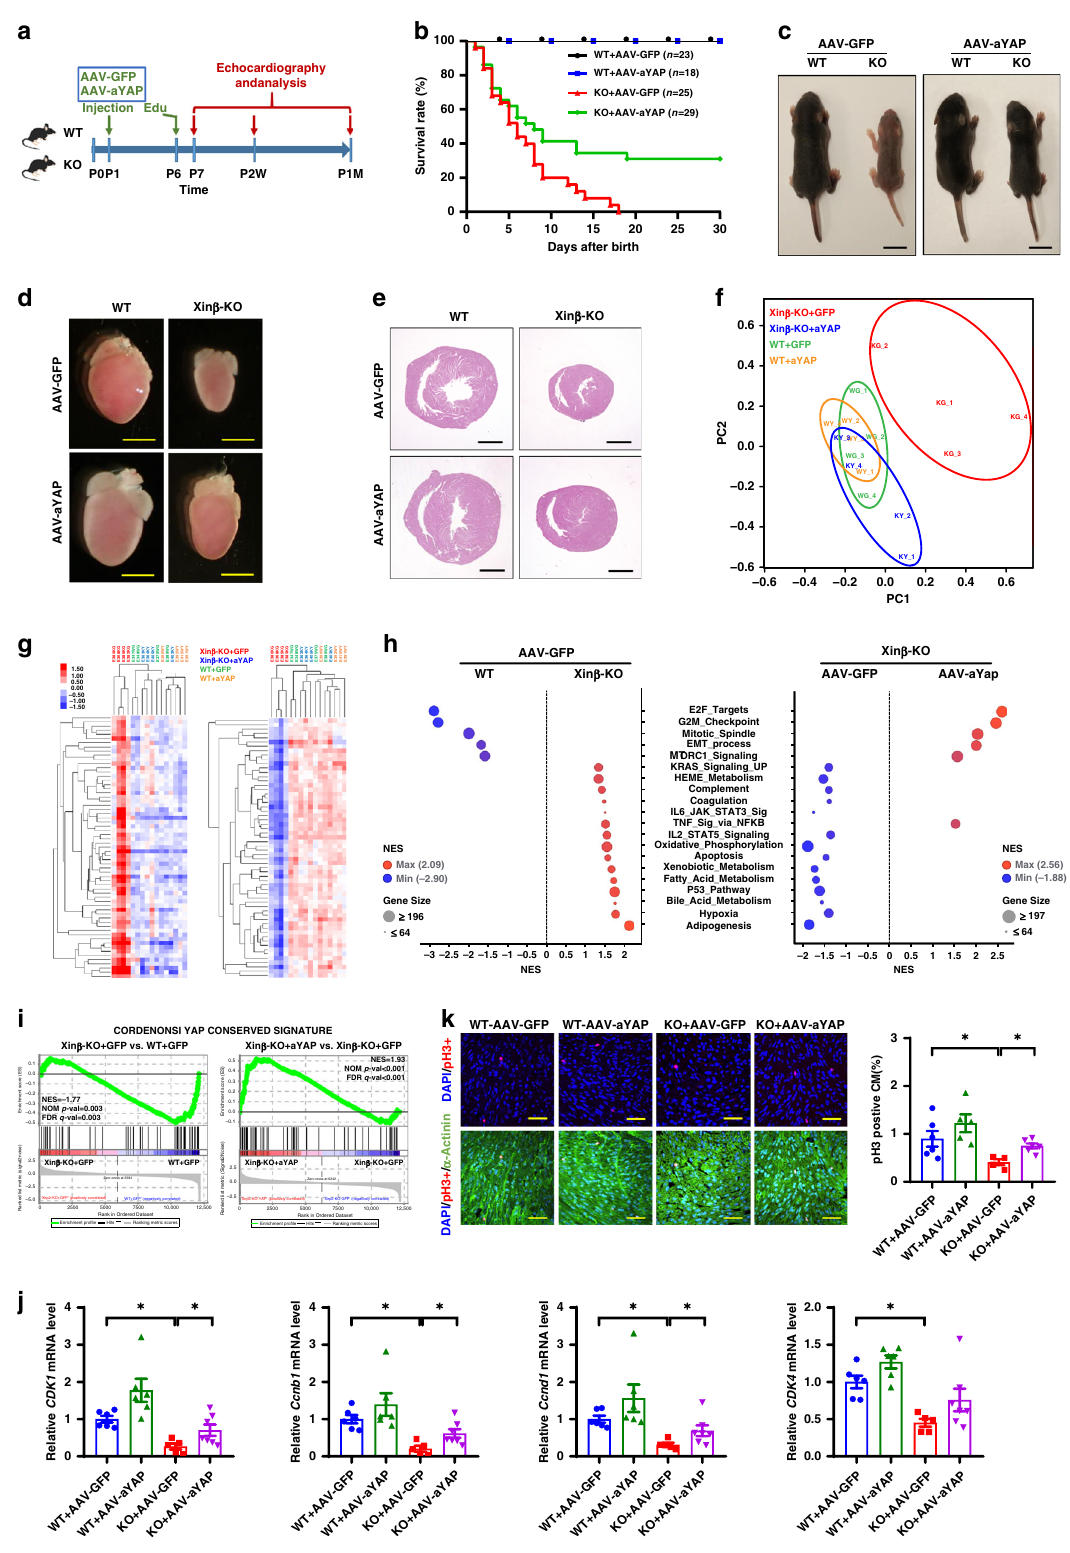
been described 6,24 . These studies showed maturation of the ICD was prevented in neonatal cardiomyocytes from Xin β -de fi cient mouse hearts, as evidenced by the failure of the adherens junction protein N-cadherin to reorganize from the lateral surface of cardiomyocytes to their